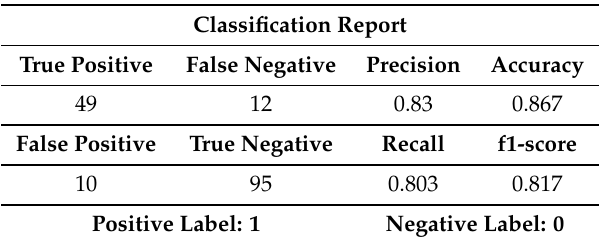
Table 14. Classification